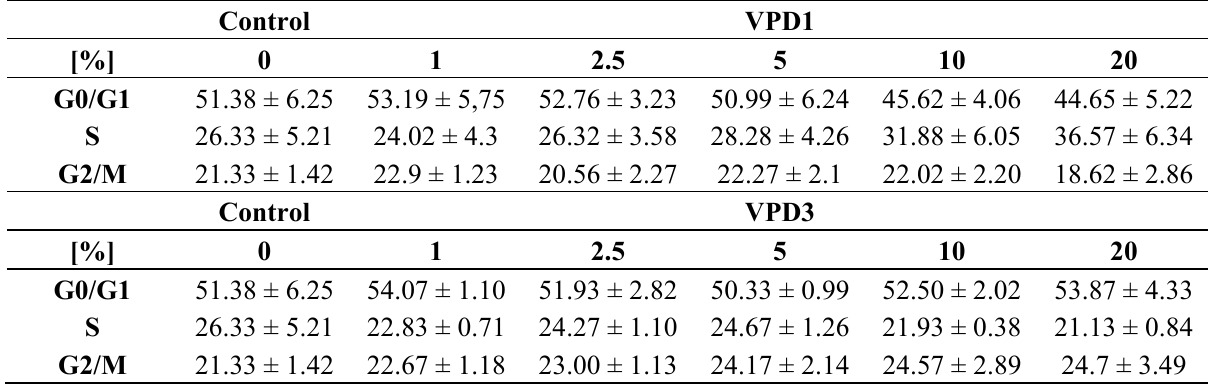
Table 2. Analysis of cell cycle phases distribution in mHippoE-18 cell line after 24